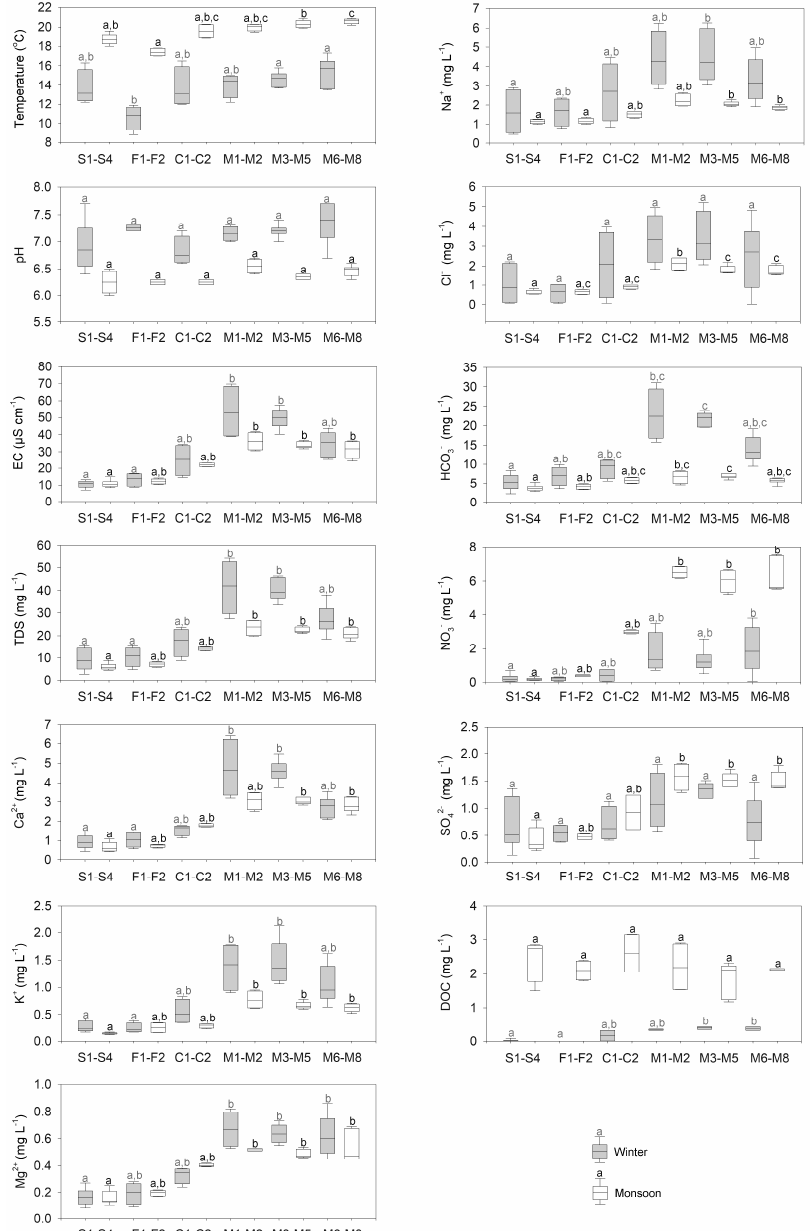
Figure 2. Comparison of surface water physico-chemical properties during winter and monsoon seasons for the Nongkrem and Umiew nested catchments system. Sites and sub-catchments as in Table 1. T—temperature, EC—electrical conductivity, TDS—total dissolved solids, and DOC—dissolved organic carbon. The line within the box represents the median and the inter quartile range, while whiskers show the minimum and maximum values. Variables with the different letters (a, b, c) are significantly different among sites within each season with p < 0.05 (based on the Kruskal-Wallis test).